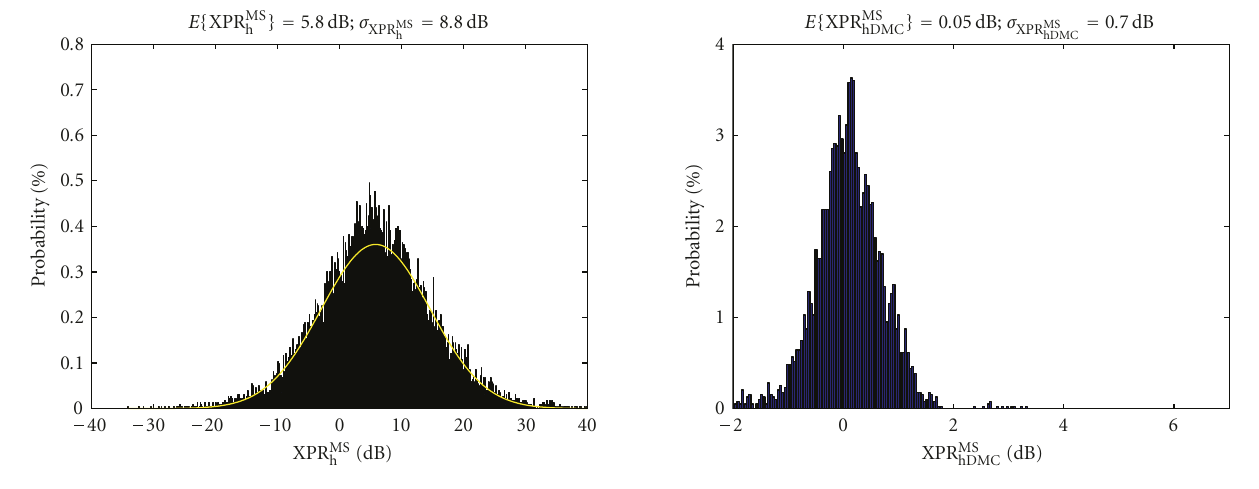
Figure 11: PDF of the XPR MS